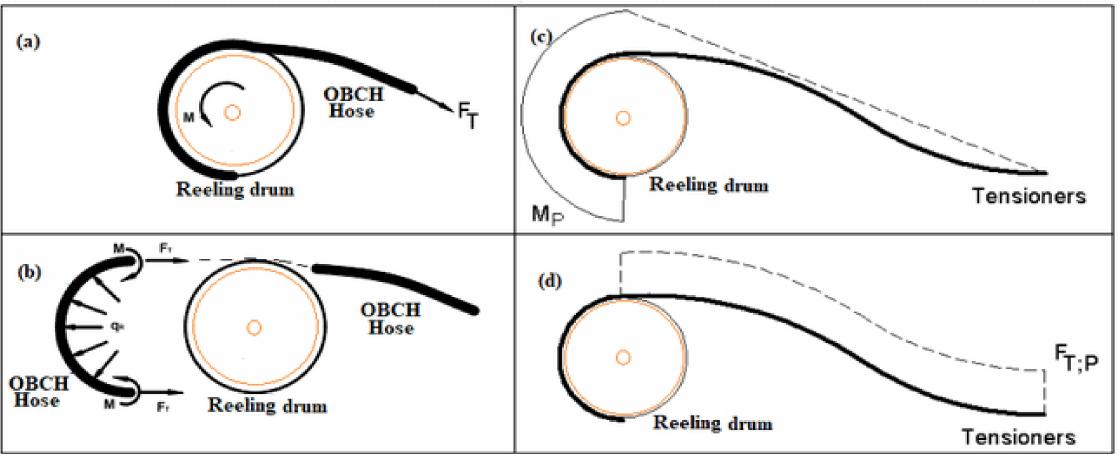
Figure 6. Hose-Pipe mechanics analysis in reeling operation on OBCH, ( a ) before spooling, ( b ) during spooling, ( c ) moment diagram during spooling-on in reality and ( d ) shear force diagram during spooling-on in